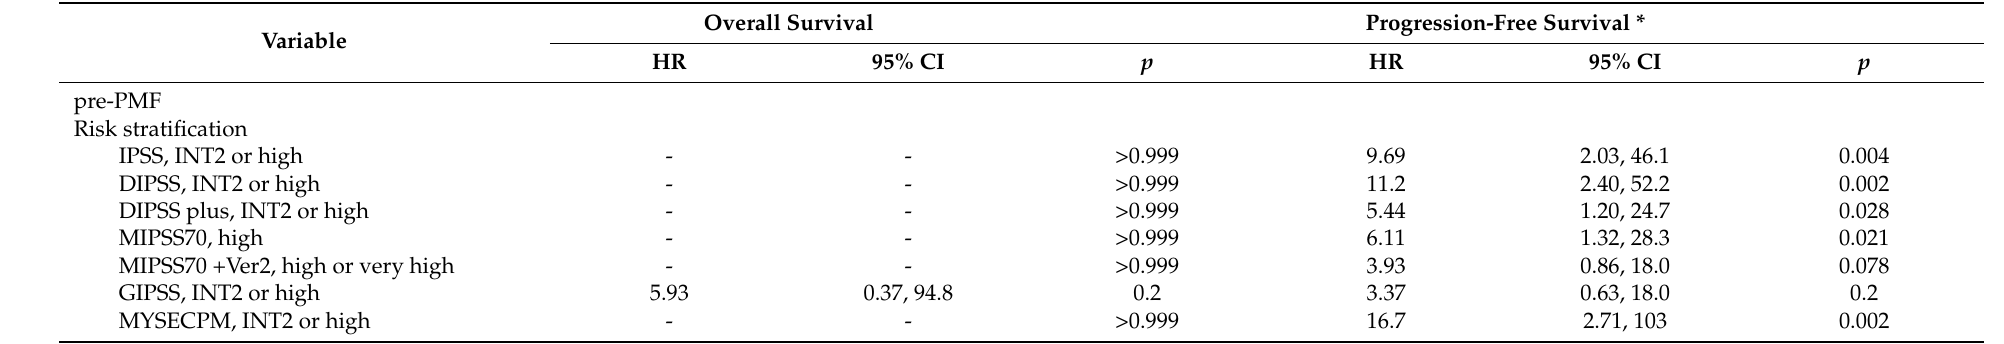
Table 3. Application of risk stratification in myelofibrosis subgroups for predicting overall and progression-free